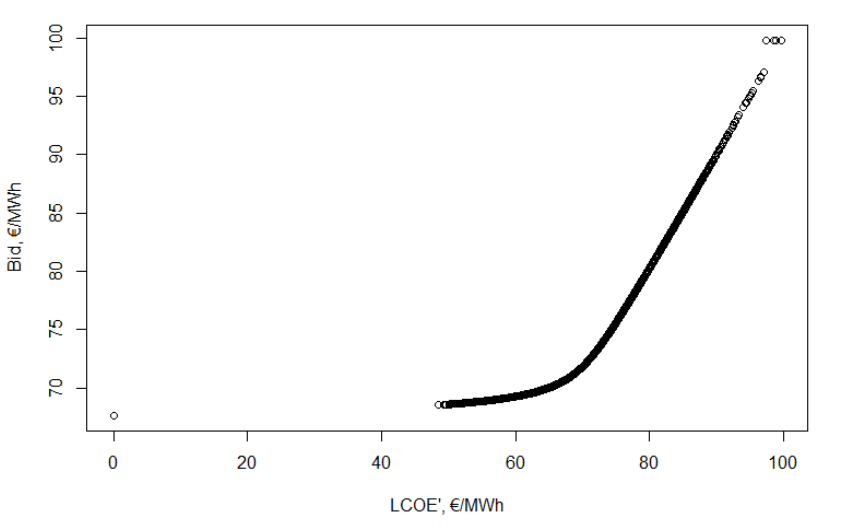
Figure 7. The optimal bid function assuming F 2 bid distribution, source: own